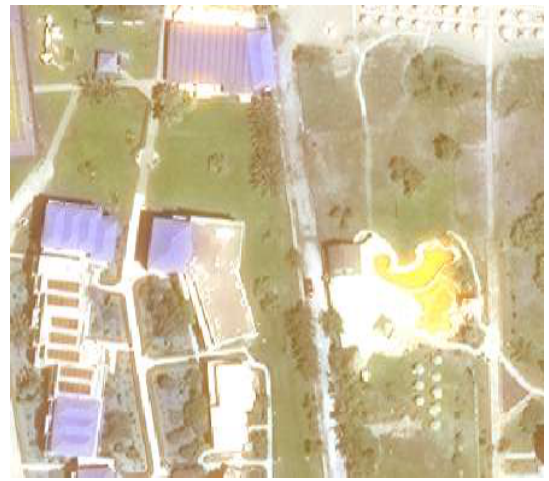
Figure 5. Example image tiles for change detection. The labelling threshold is equal to 10% of pixels differing in value more than